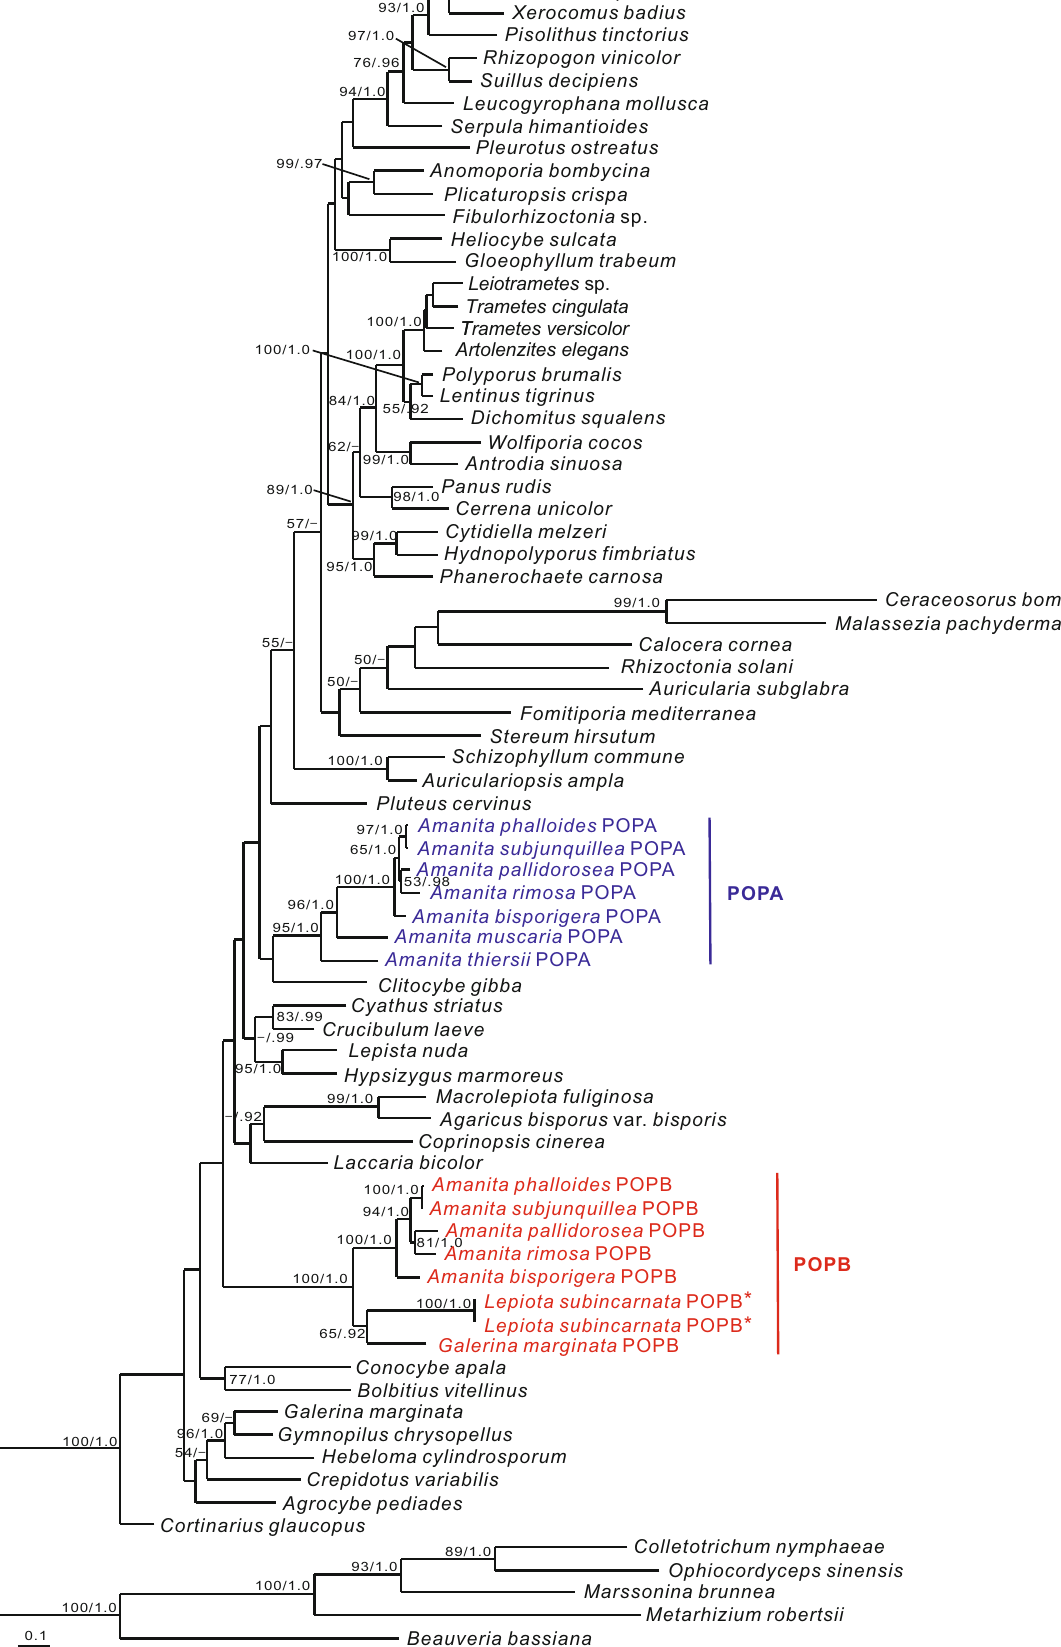
Fig. 3. Phylogeny of macrofungi inferred from maximum likelihood (ML) analysis based on amino acid sequences of POP gene .